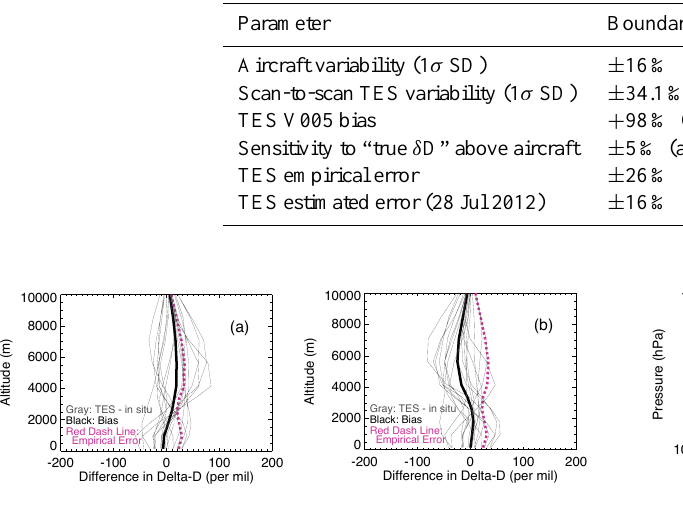
Table 4. Error Budget for Aura TES V005 δ D. Error terms are shown for both the boundary layer (up to 1700m) and the free troposphere from 2500m altitude up to the aircraft ceiling of 5000m. The aircraft variability comes from seven aircraft flights over the Alaskan interior boreal forest (see Table 1 and Sect. 4.1). The scan-to-scan TES variability includes 27 TES transects and 253 scans of good quality (see Sect. 4.1). The TES V005 bias is calculated to minimize the differences between TES and aircraft with averaging kernel applied for 16 matches (see Sect. 4.3). The sensitivity to assumptions about the true profile above the aircraft ceiling is adapted from Fig. 5 (Sect. 4.4). The TES empirical error is calculated from the 16 good TES–aircraft matches; see Eq. (7). The TES estimated error is shown here only for the 28 July 2012 TES special observation but is typical of the entire set of measurements.